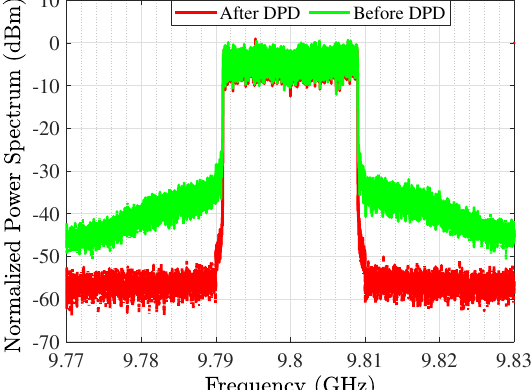
Figure 12. Output spectrum presentation with 20 MHz LTE signal before and after DPD.